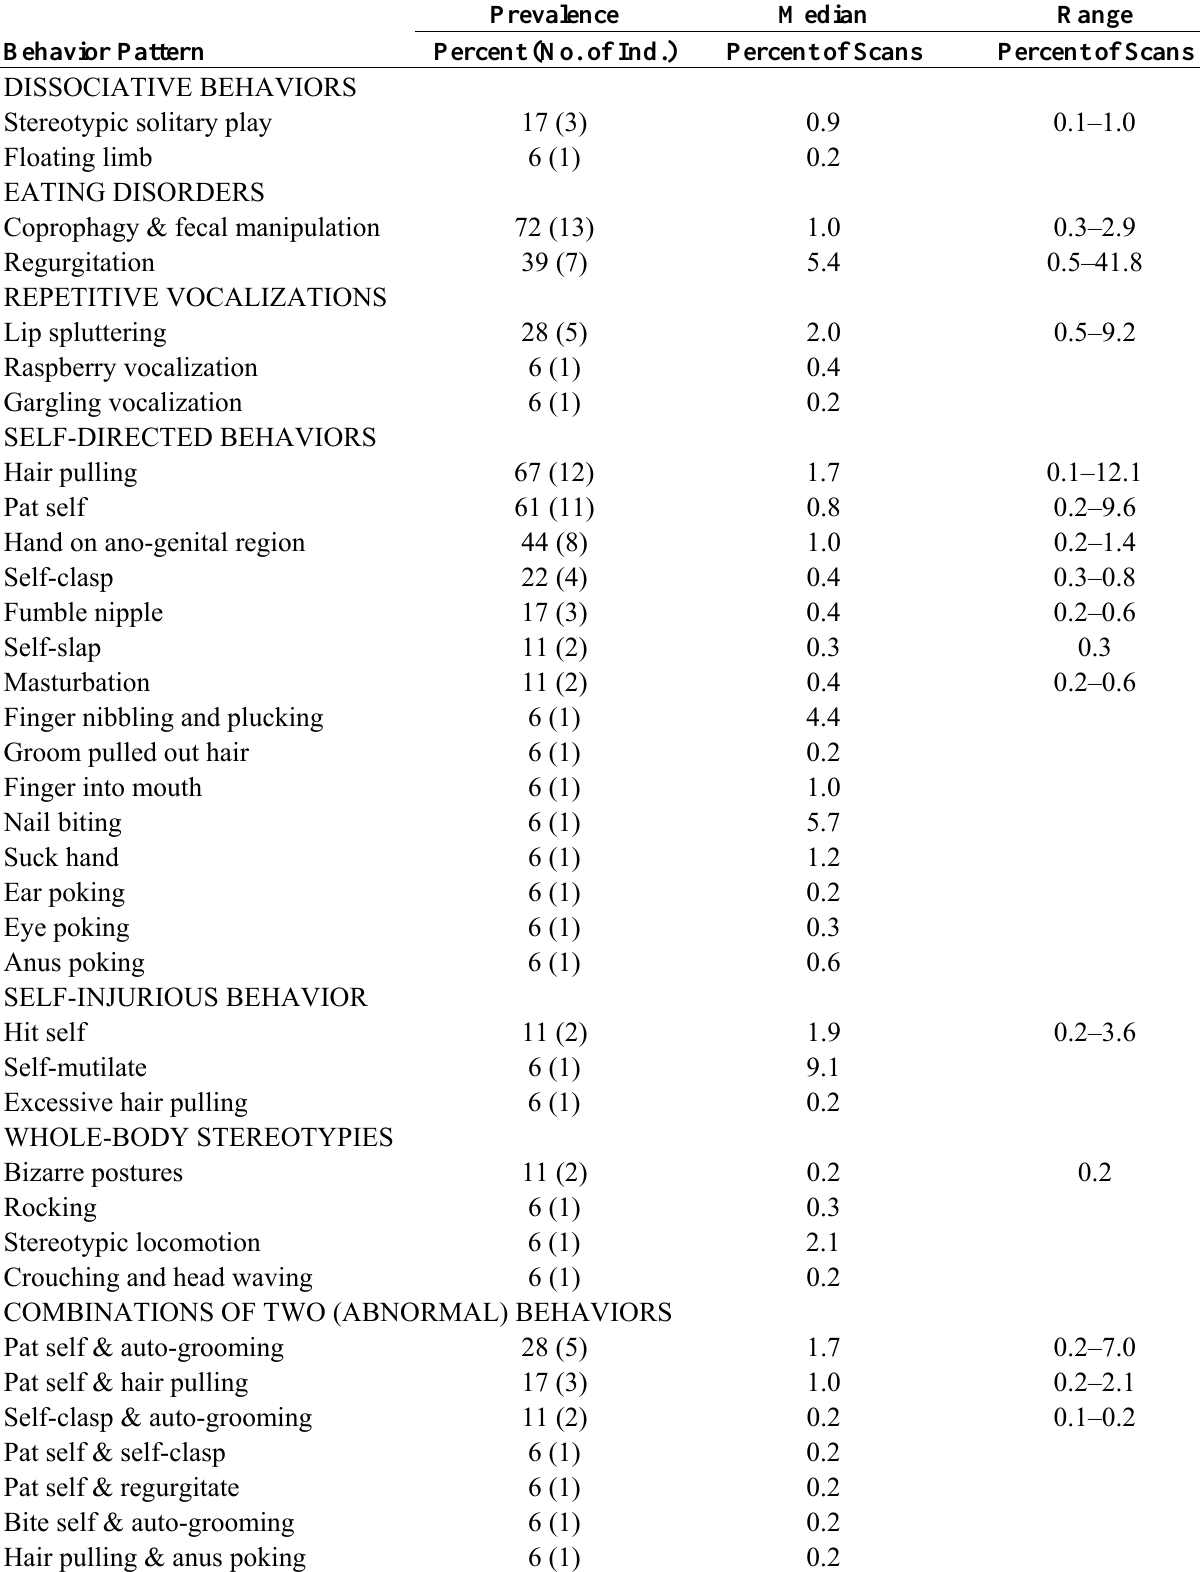
Table 3. Prevalence of abnormal behavior patterns, expressed as the proportion of individuals who performed a specific abnormal behavior pattern relating to the total number of study